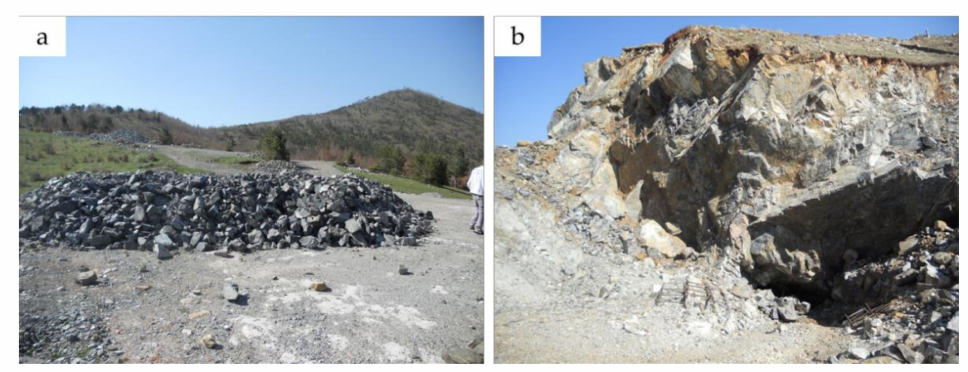
Figure 4. Pictures of ( a ) Stock of chromitite ore outside of Iballe mine; ( b ) fresh dunite outcrop at